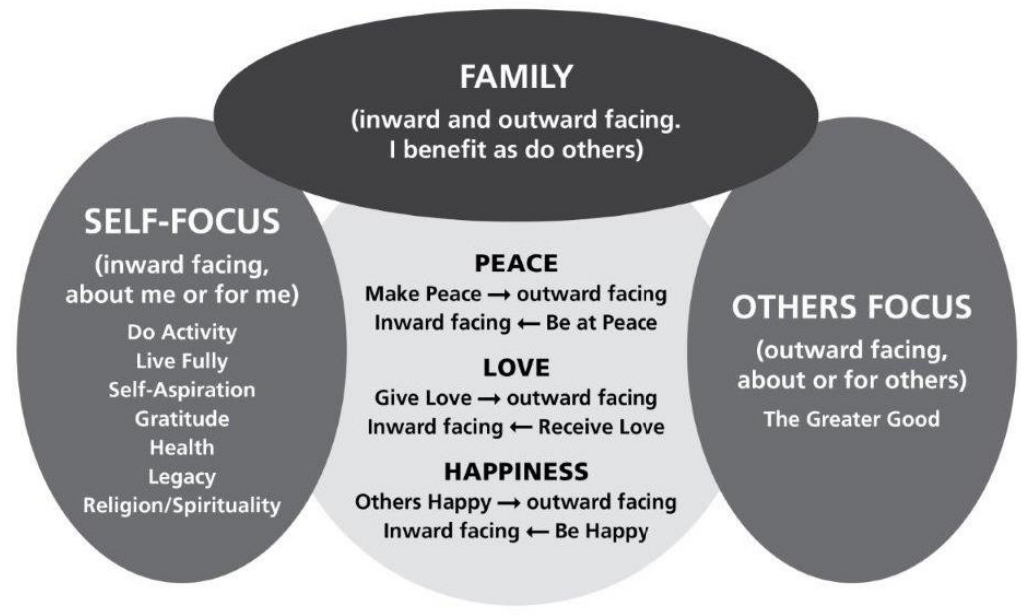
Figure 1. Visual representation of the generated themes.